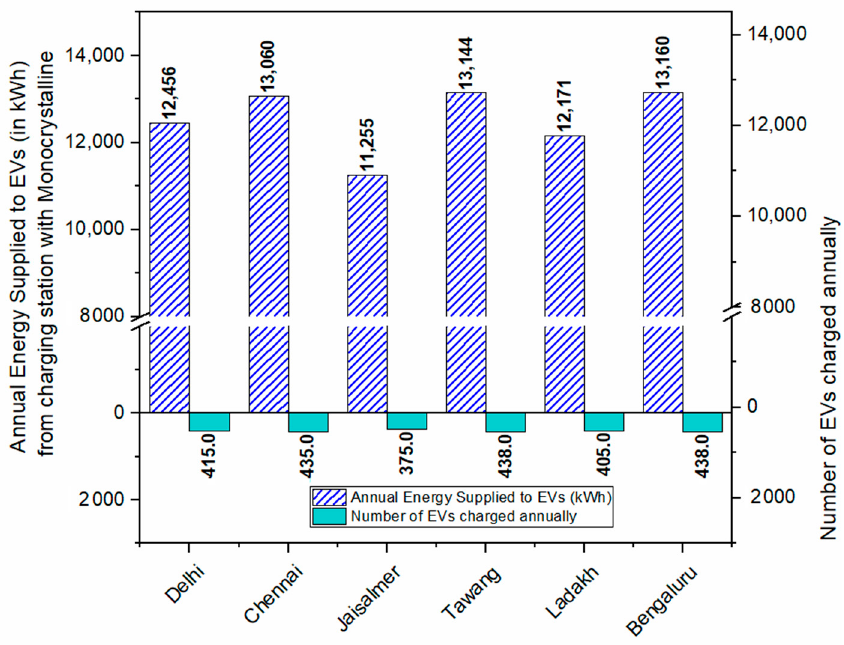
Figure 14. Annual energy supplied to EVs by the charging station using monocrystalline panels.